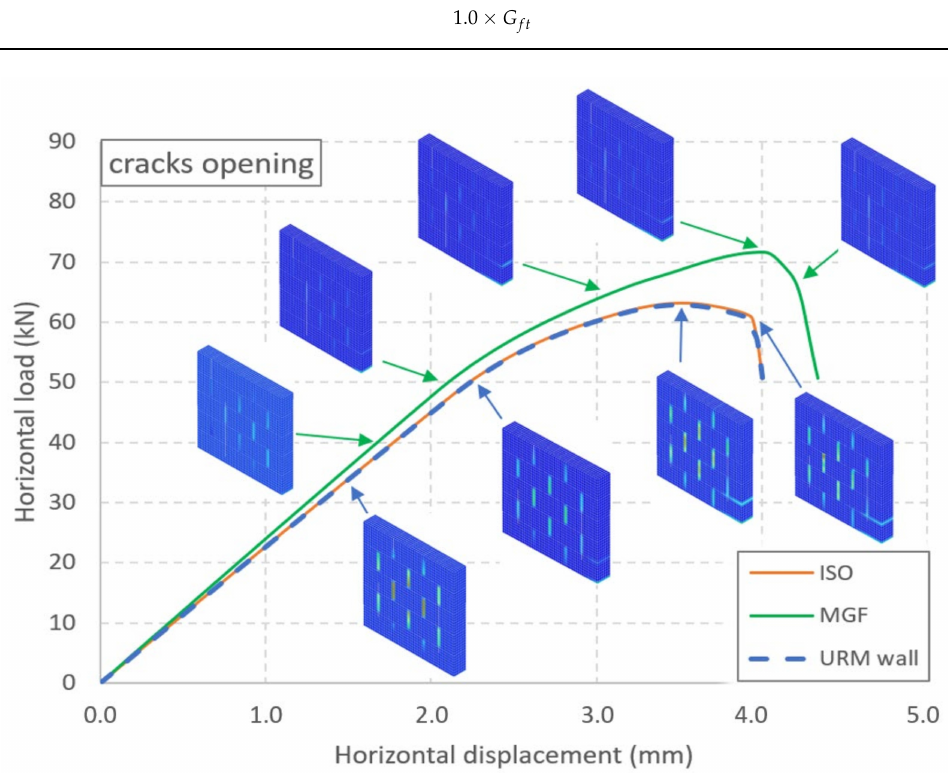
Figure 9. Numerical force vs. displacement curves for the three types of wall and the evolution of the opening of the cracks for the URM and MGF